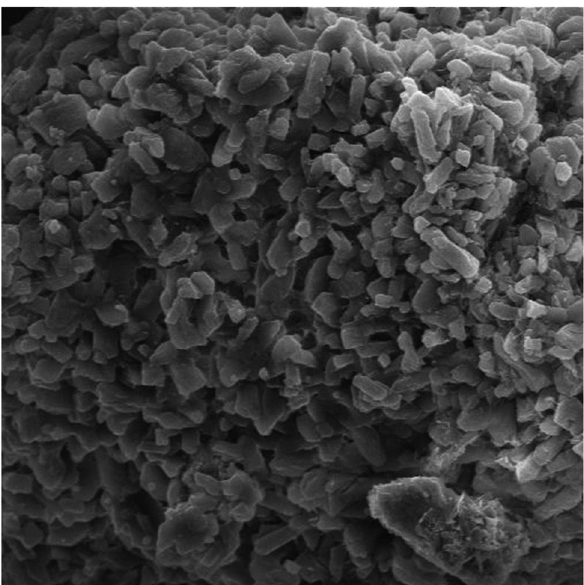
Figure 2: SEM micrograph of chitosan - based fenoxaprop - p - ethyl nanoparticles.